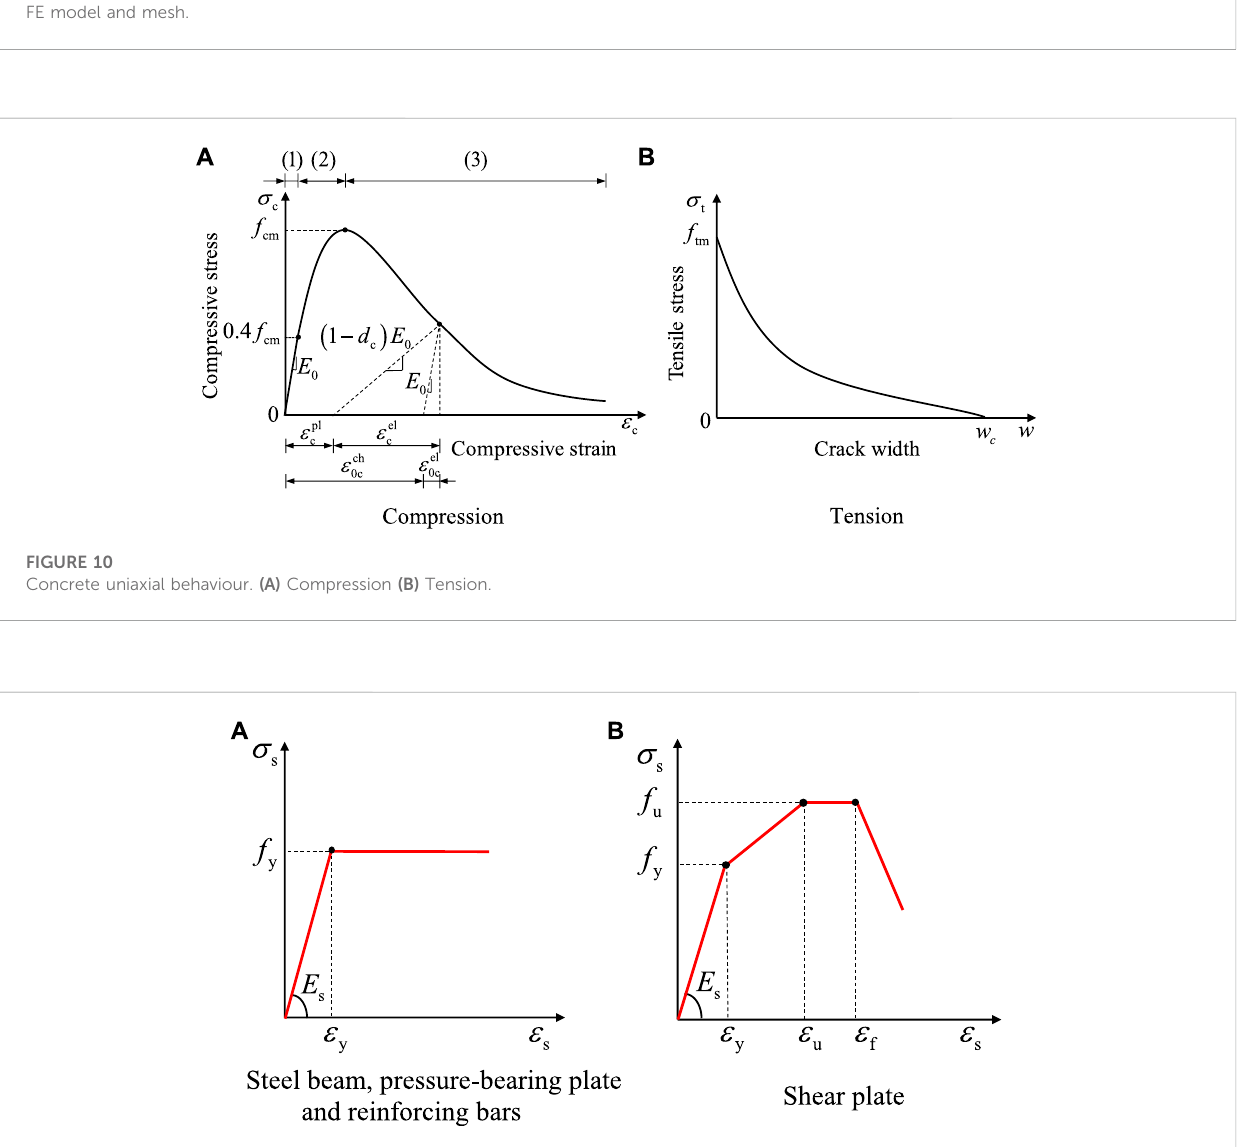
FIGURE 9 FE model and mesh.